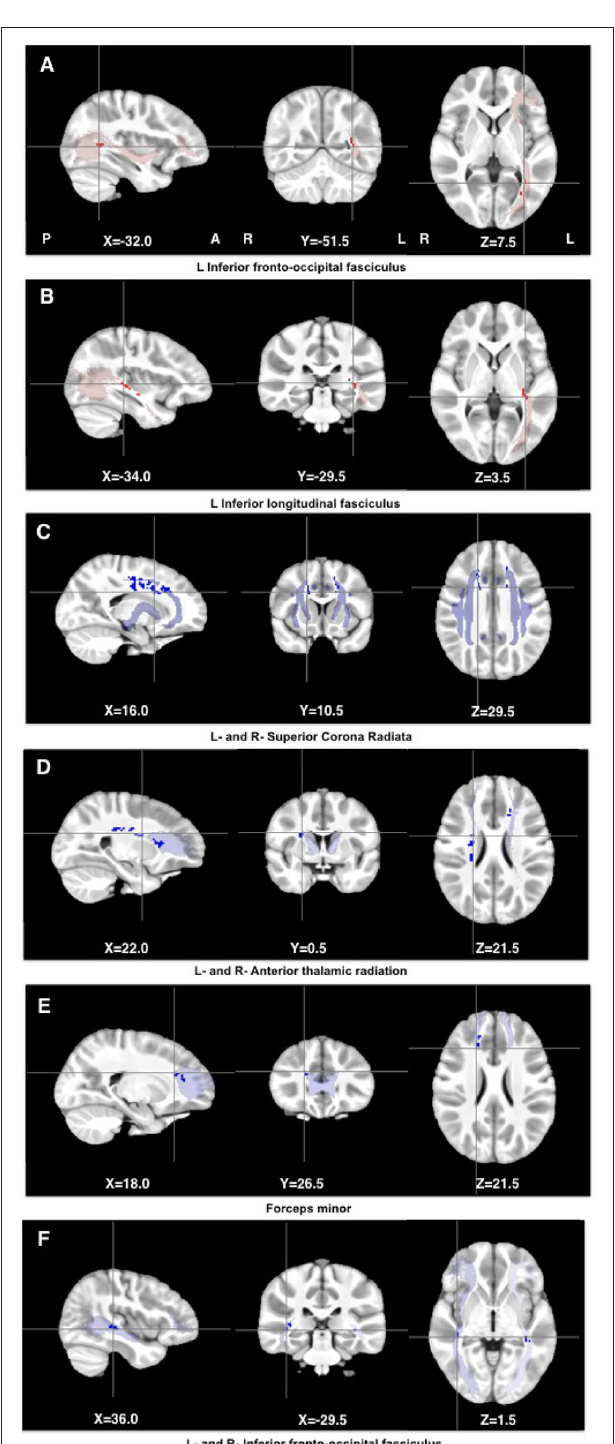
FIGURE 1 | Clusters showing lower FA (red) and higher MD (blue) in HIV infected children compared to controls. The clusters were overlayed on masks of the corresponding tracts (JHU White-Matter Tractography